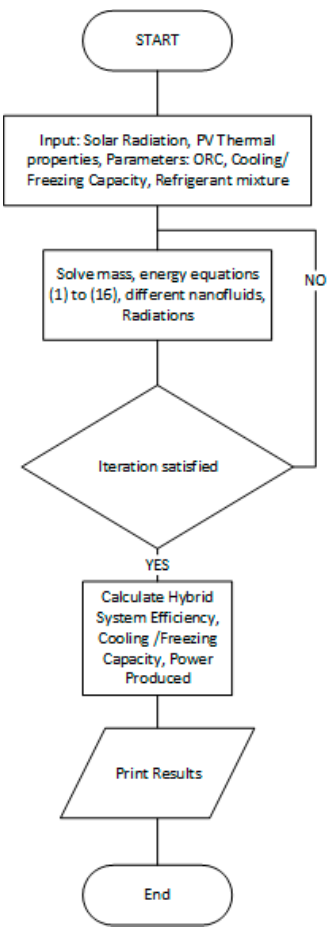
Figure 2. Logical diagram for numerical solution.